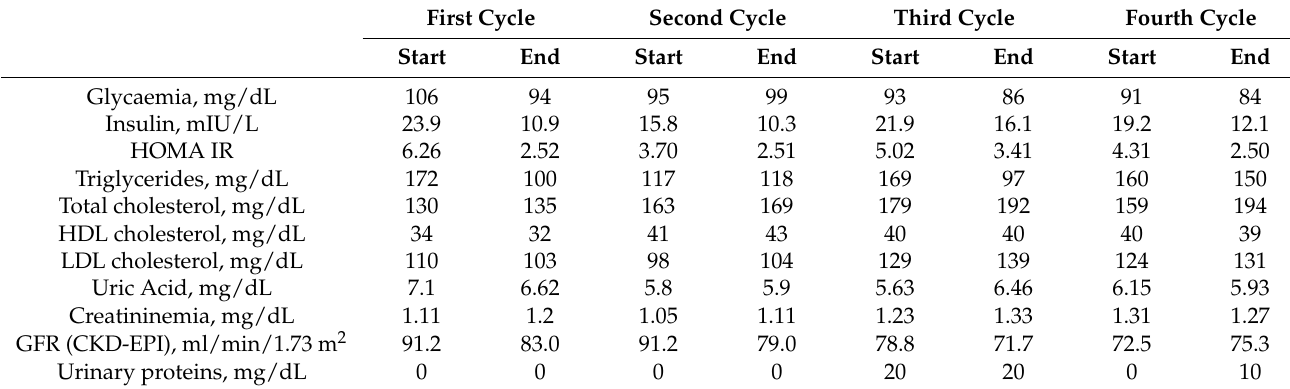
Table 1. Laboratory tests during diet cycles.